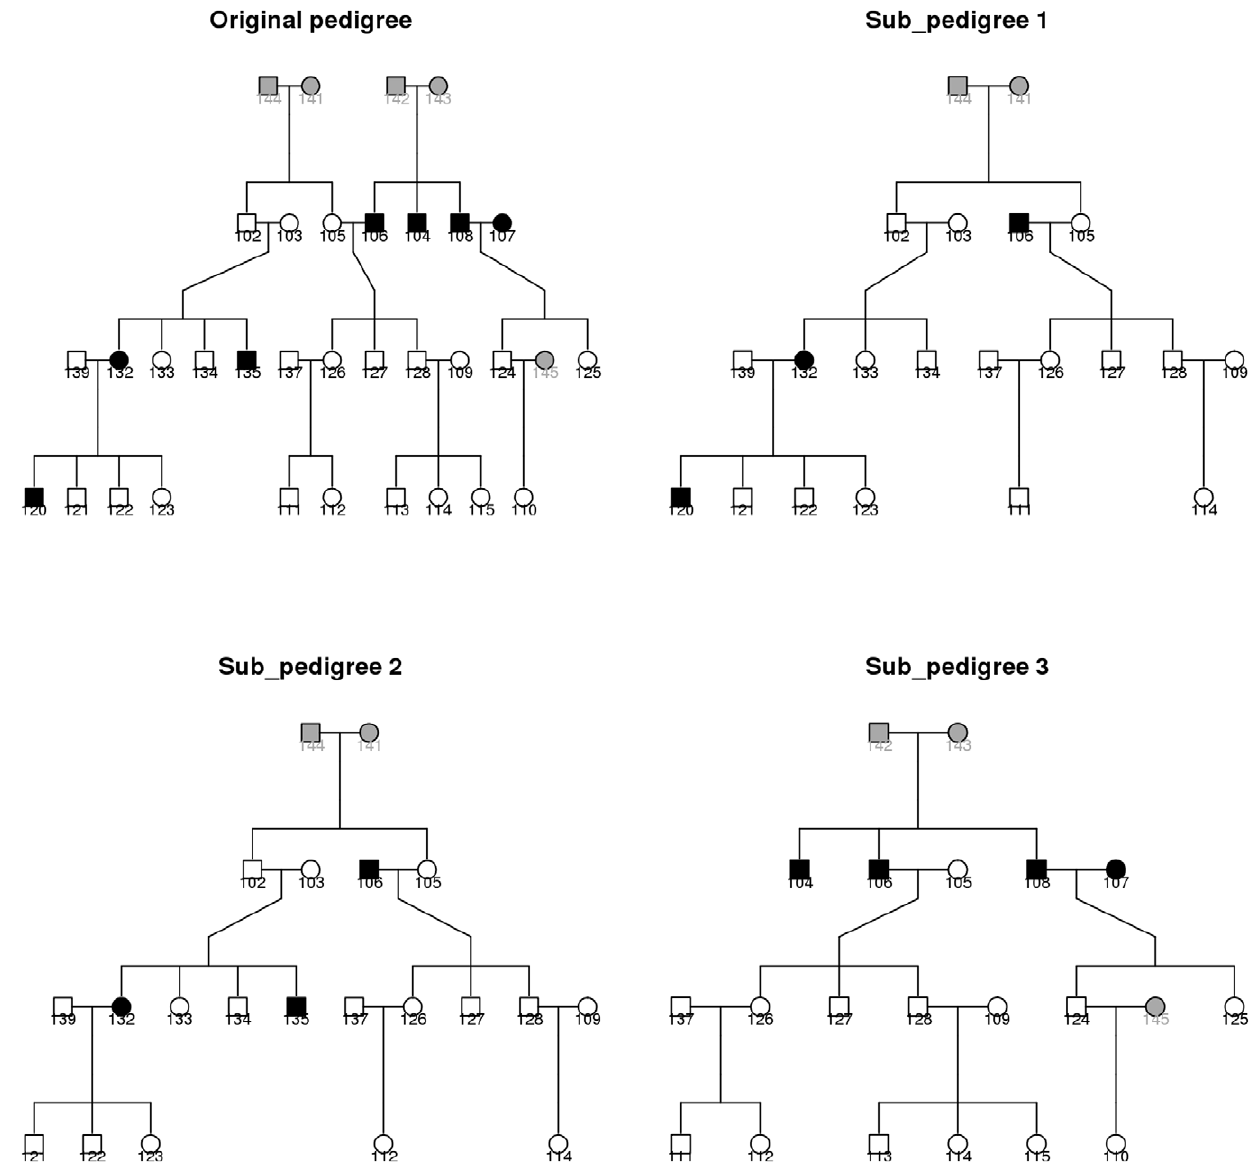
Figure 5. Example for pedigree splitting and trimming.